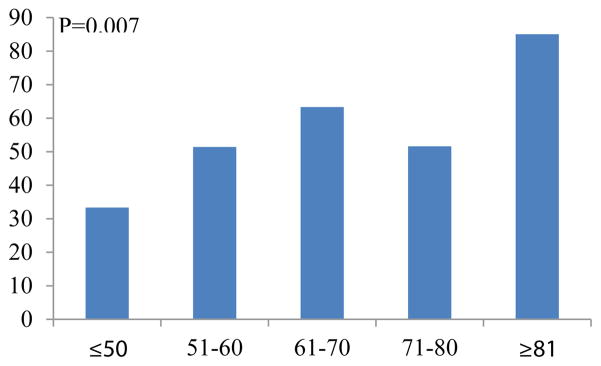
Proportion of patients with any deficits.